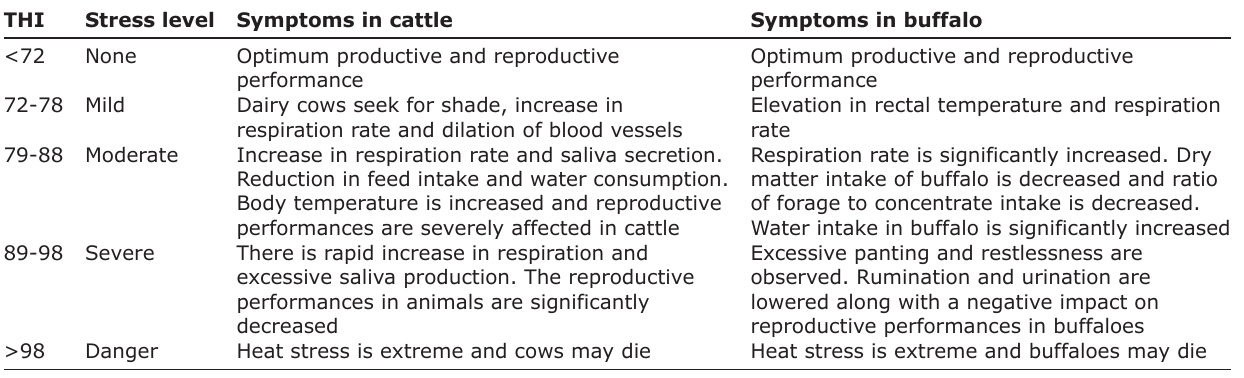
Table-2: Classification of zones based on THI values in cattle with THI model [27]. THI Stress level Symptoms in